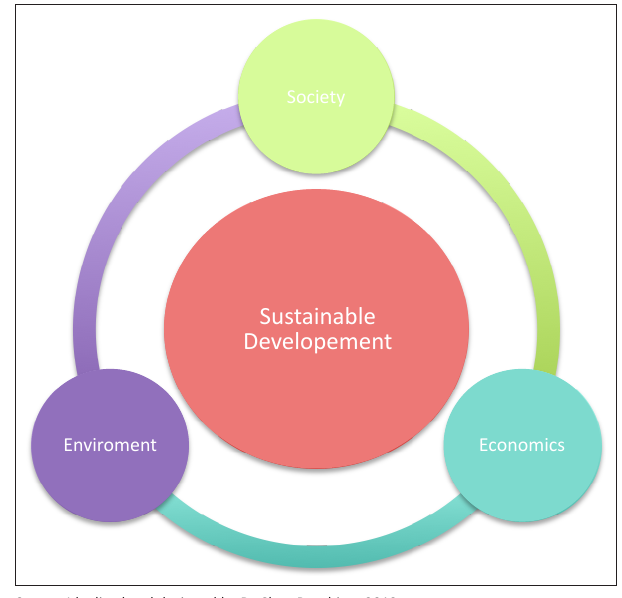
FIGURE 1: Triangulation of elements in Sustainable